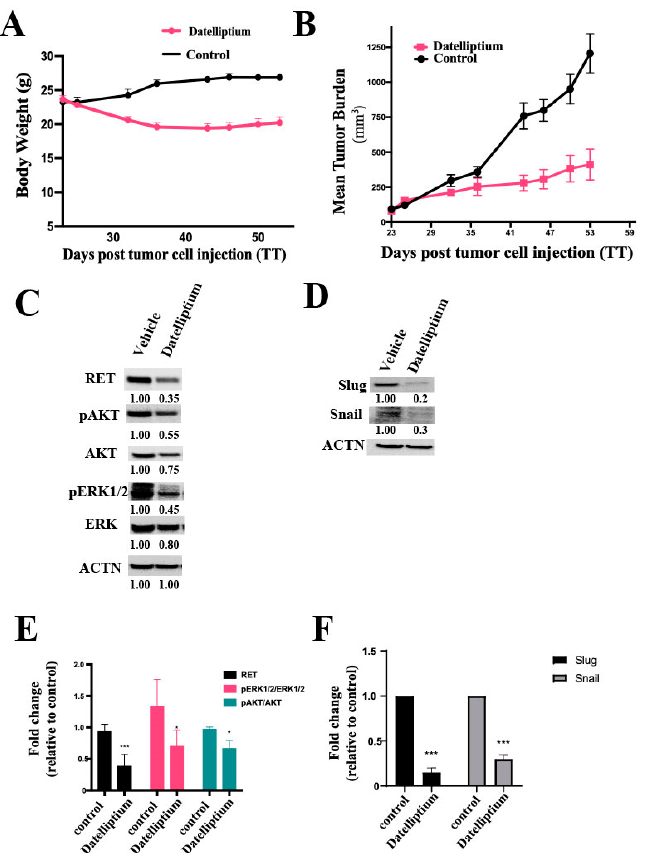
Figure 6. Effect of datelliptium on medullary thyroid tumor growth in vivo. ( A ) Average weight of mice in the control group and datelliptium (6 mg/kg) treated group; x- and y-axes illustrate days post-treatment and the average weight of mice, respectively. ( B ) MTC tumor growth curves of the vehicle treated group and datelliptium (6 mg/kg) treated group; x-axes and y-axes represent the number of days after drug administration and the average tumor volume, respectively. Data are mean ± SEM of 6 different mice. ( C ) Western blot analysis to evaluate RET, AKT, pAKT, pERK1/2, ERK1/2, and actin expression of the tumor tissues post-treatment. ( D ) Western blot analysis to selected EMT biomarker Slug and Snail. ( E ) and ( F ) Densitometry analysis of ( C ) and ( D ), respectively. All proteins were normalized to their basal expression ( n = 3, *** p < 0.001, and * p ≤ 0.5).